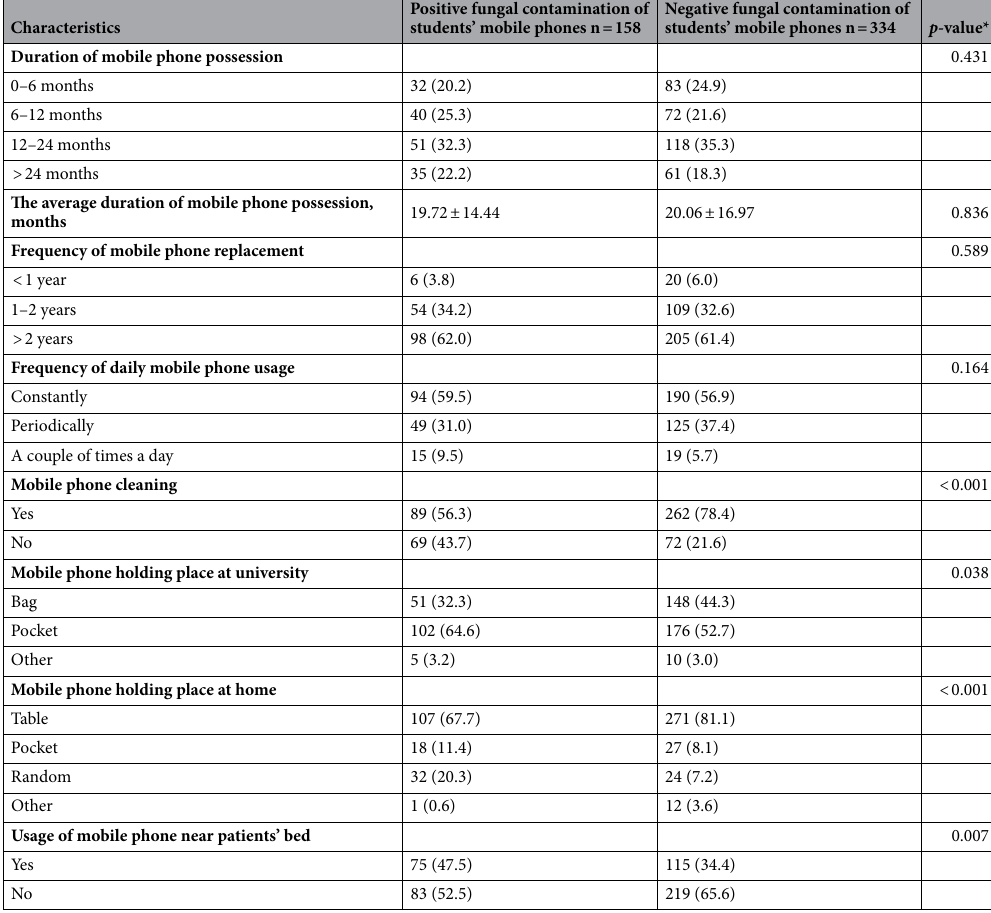
Table 1. Distribution of characteristics regarding mobile phone usage in 492 medical students by presence of fungal contamination on students’ mobile phones. *According to the univariate logistic regression analysis for categorical variable, and independent samples t-test for continuous variable. Numerical data are presented as mean ± standard deviation, categorical as frequency No. (%).